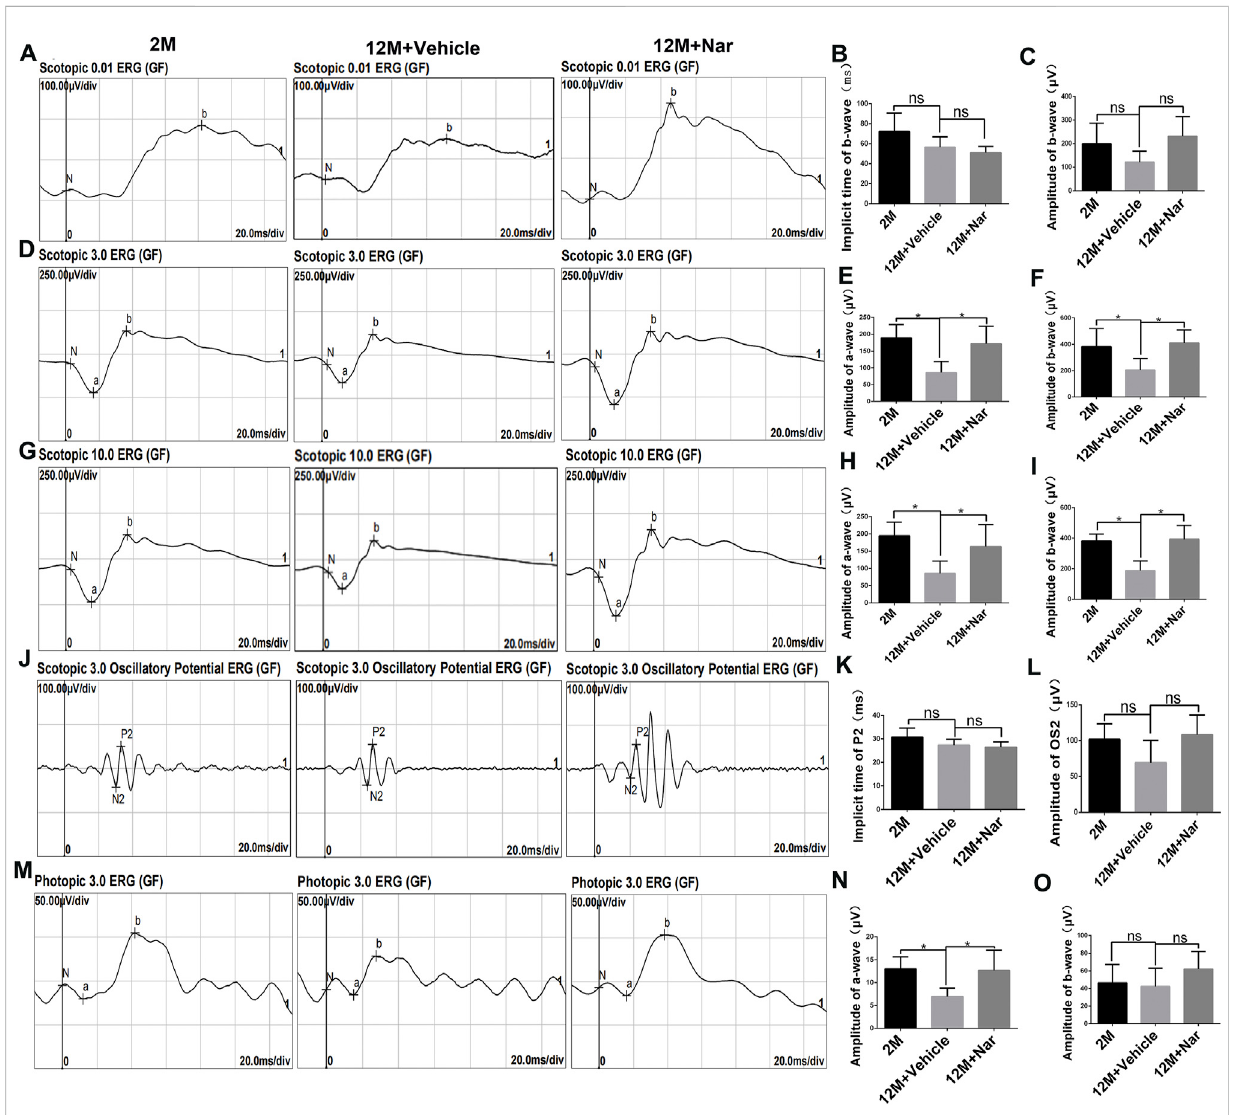
FIGURE 1 Naringenin (Nar) preserved retinal function of aging mice. (A) Representative scotopic 0.01 electroretinogram (ERG) waveforms, (B) the implicit time of b-wave, and (C) the amplitude of b-wave. (D) Representative scotopic 3.0 ERG (the combined rod-cone response [standard fl ash]) waveforms, the amplitudes of (E) a-wave and (F) b-wave. (G) Representative scotopic 10.0 ERG waveforms, the amplitudes of (H) a-wave and (I) b-wave. (J) Representative scotopic 3.0 oscillatory potential ERG, (K) the implicit time of P2-wave, and (L) the amplitude of OS2- wave. (M) Representative photopic 3.0 ERG waveforms, the amplitudes of (N) a-wave and (O) b-wave. 2 M: normal 2-month-old mice, 12 M: normal 12-month-old mice, 12 M + Vehicle: 0.5% CMC-Na treated 12-month-old mice, 12 M + Naringenin: Naringenin (100 mg/kg/day) treated 12-months-old mice. The results are expressed as the mean values ± SEM, n = 6. The results are expressed as the mean values ± SEM, n = 6. One-way ANOVA, post hoc Tukey ’ s test (* p <